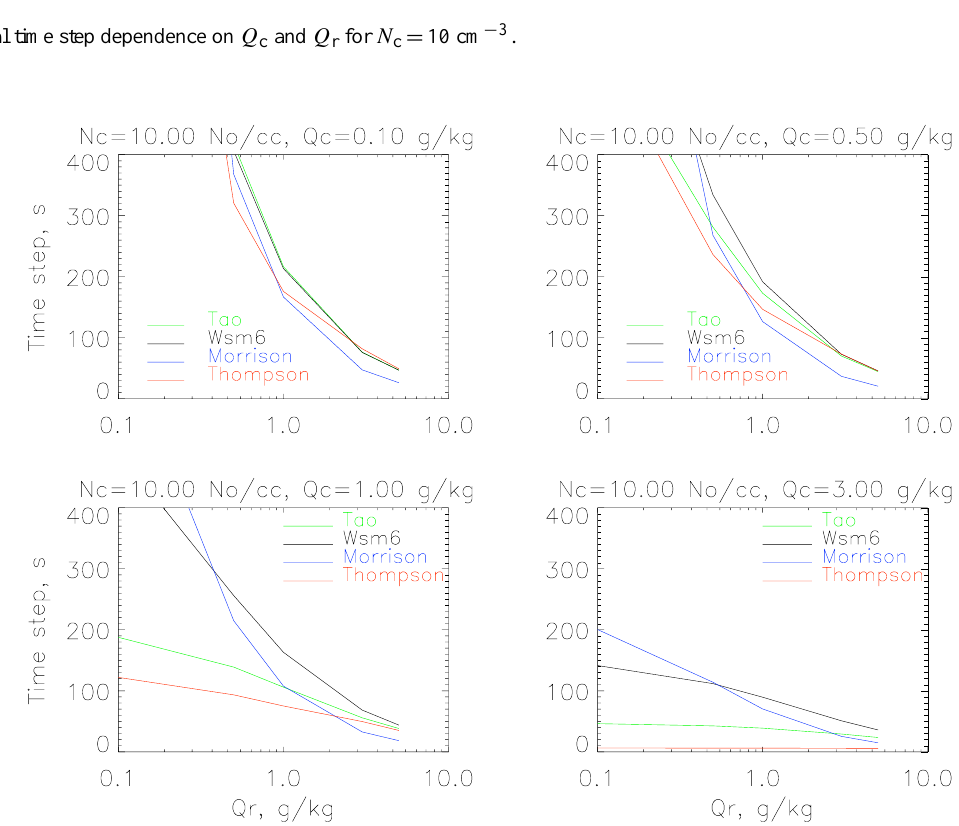
Fig. 2. Maximal time step dependence on Q r and Q c for N c = 10 cm − 3